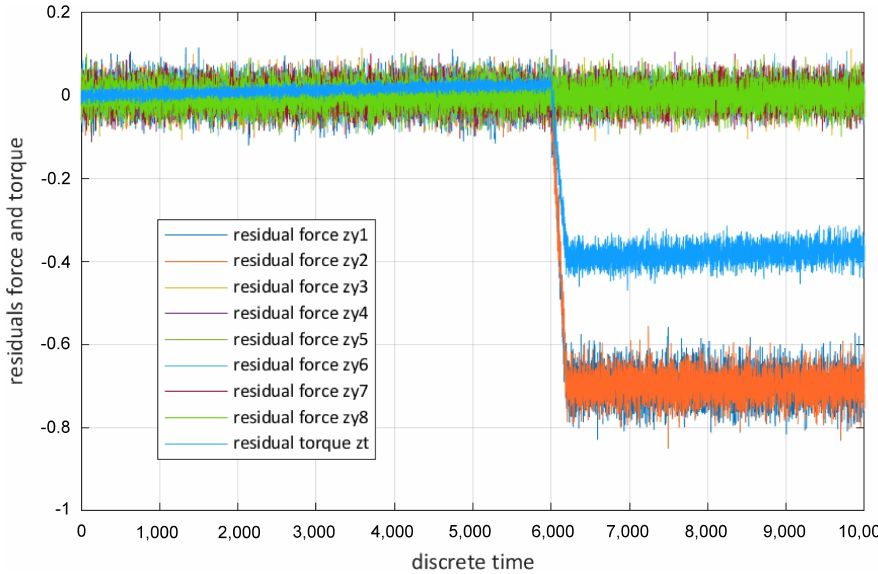
Figure 7. Residuals generated by the virtual